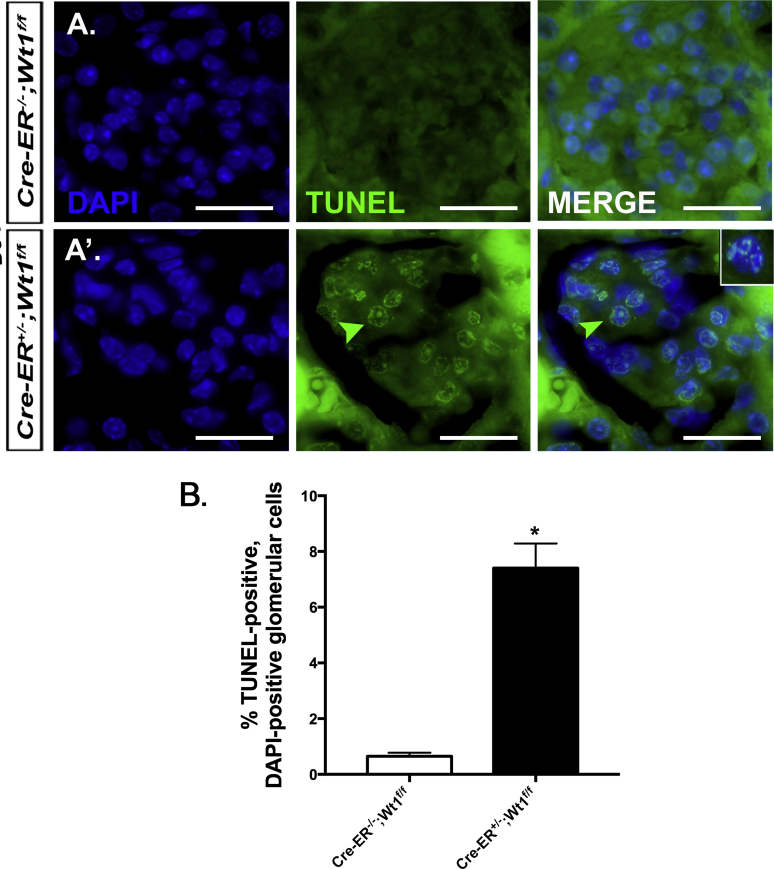
Terminal deoxynucleotidyltransferase–mediated 2′-deoxyuridine 5′-triphosphate nick end-labeling (TUNEL)-positive cells in glomeruli of CAGG-CreERTM+/−;Wt1f/f transgenic mice. (A,A′) TUNEL-positive and 4′,6-diamidino-2-phenylindole (DAPI)-positive cells (inset) in mutant mice (A′) at day 5 postinduction compared with controls (A). (B) Quantitative graph showing increased proportion of median number of TUNEL-positive podocytes. Bars represent the median of each group. Error bars represent interquartile ranges, *P < 0.0001, Mann-Whitney U test. See also Figure 2c for TUNEL-positive primary podocytes of mutant versus control mice.